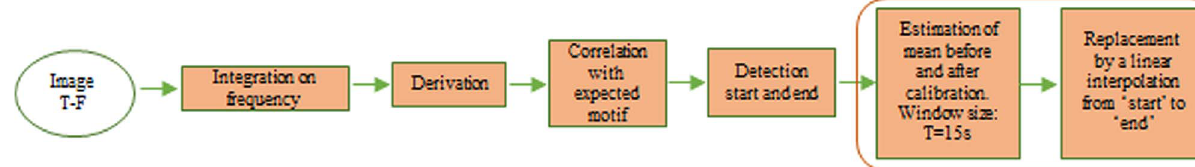
Fig. A.1. Synopsis of eliminating calibration signals.